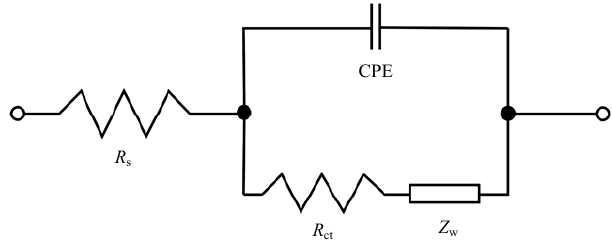
Figure 7. The equivalent circuit of MFCs under different conditions.